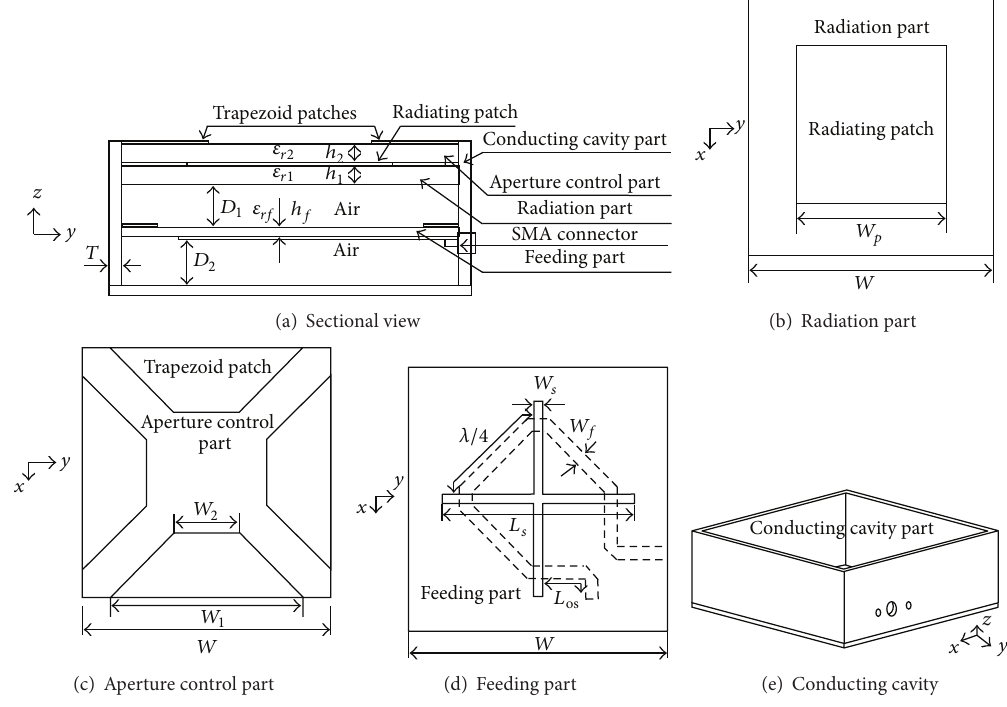
Figure 1: Structure of the